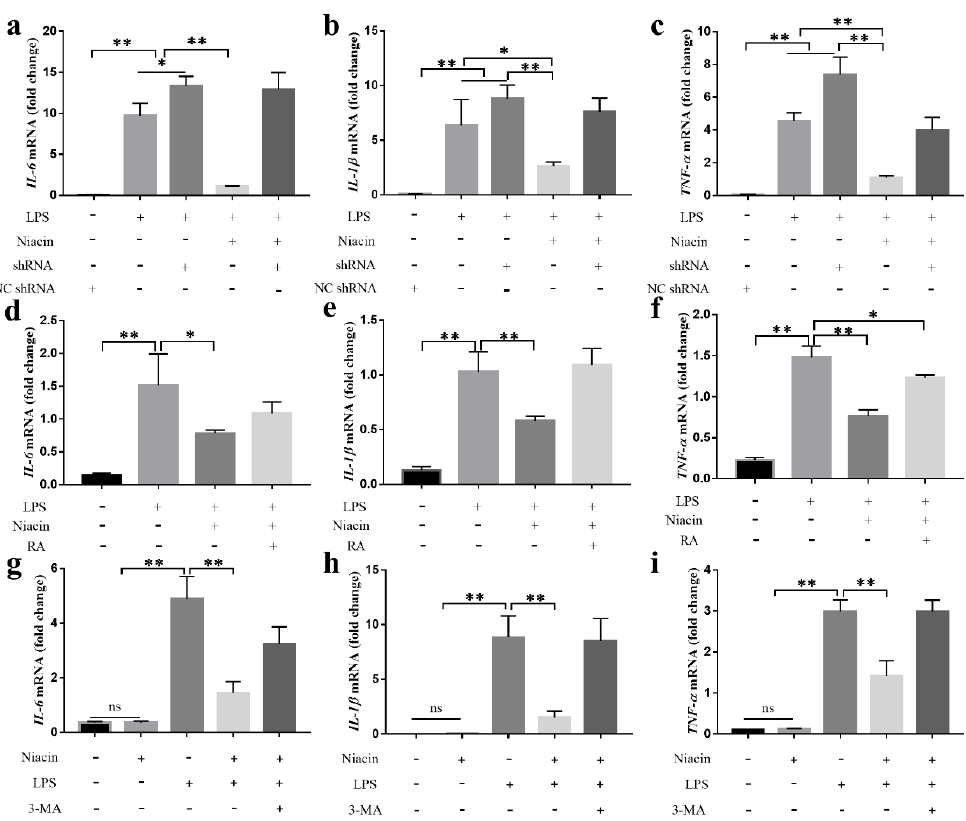
Figure 2. E ff ects of autophagy, GPR109A, and NRF2 on BMECs inflammation. ( a – i ) The bovine mammary epithelial cells (BMECs) were pre-treated with niacin and NC shRNA, shRNA, retinoic acid (RA), or 3-methyladenine (3-MA) for 1 h and then stimulated with LPS for 24 h. The mRNA levels of IL-6, IL-1 β , and TNF- α were determined by qRT-PCR. The mRNA levels of IL-6, IL-1 β , and TNF- α were normalized to the level of β -actin . The values are presented as the means ± SD (* p < 0.05 and ** p < 0.01).